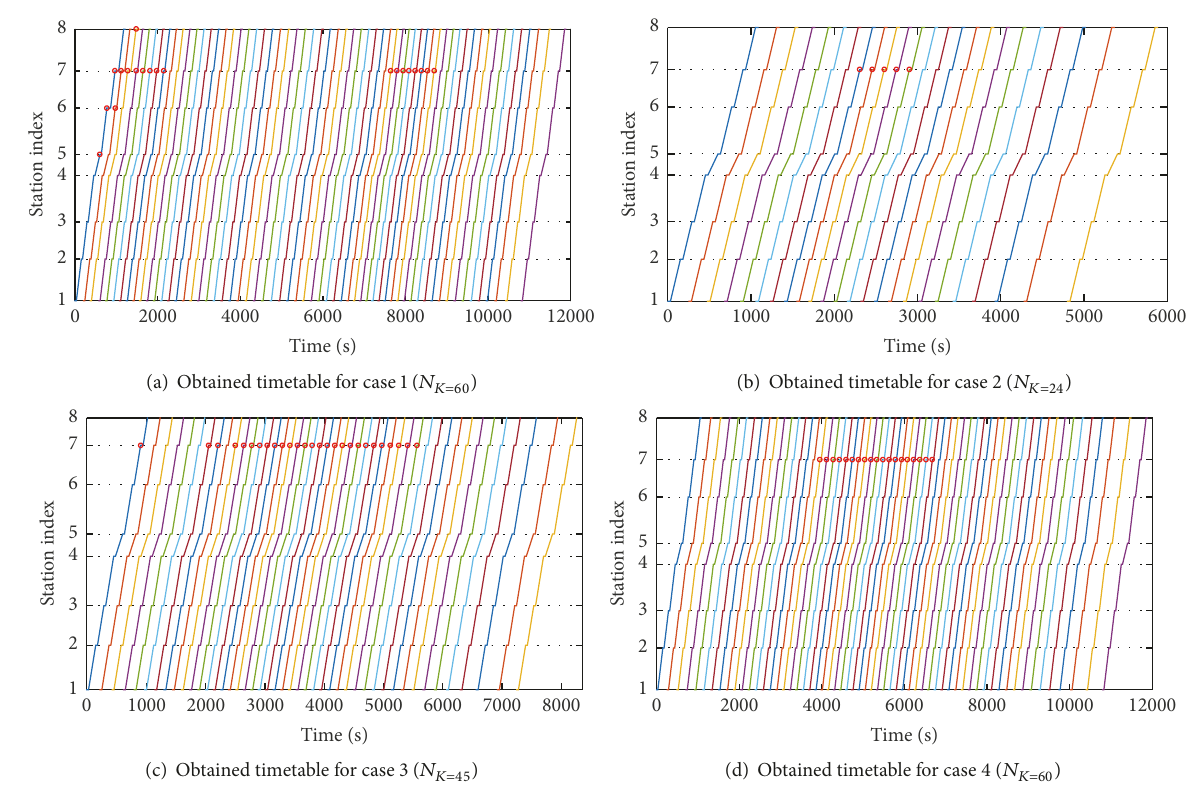
Figure 8: Obtained timetables for different cases.